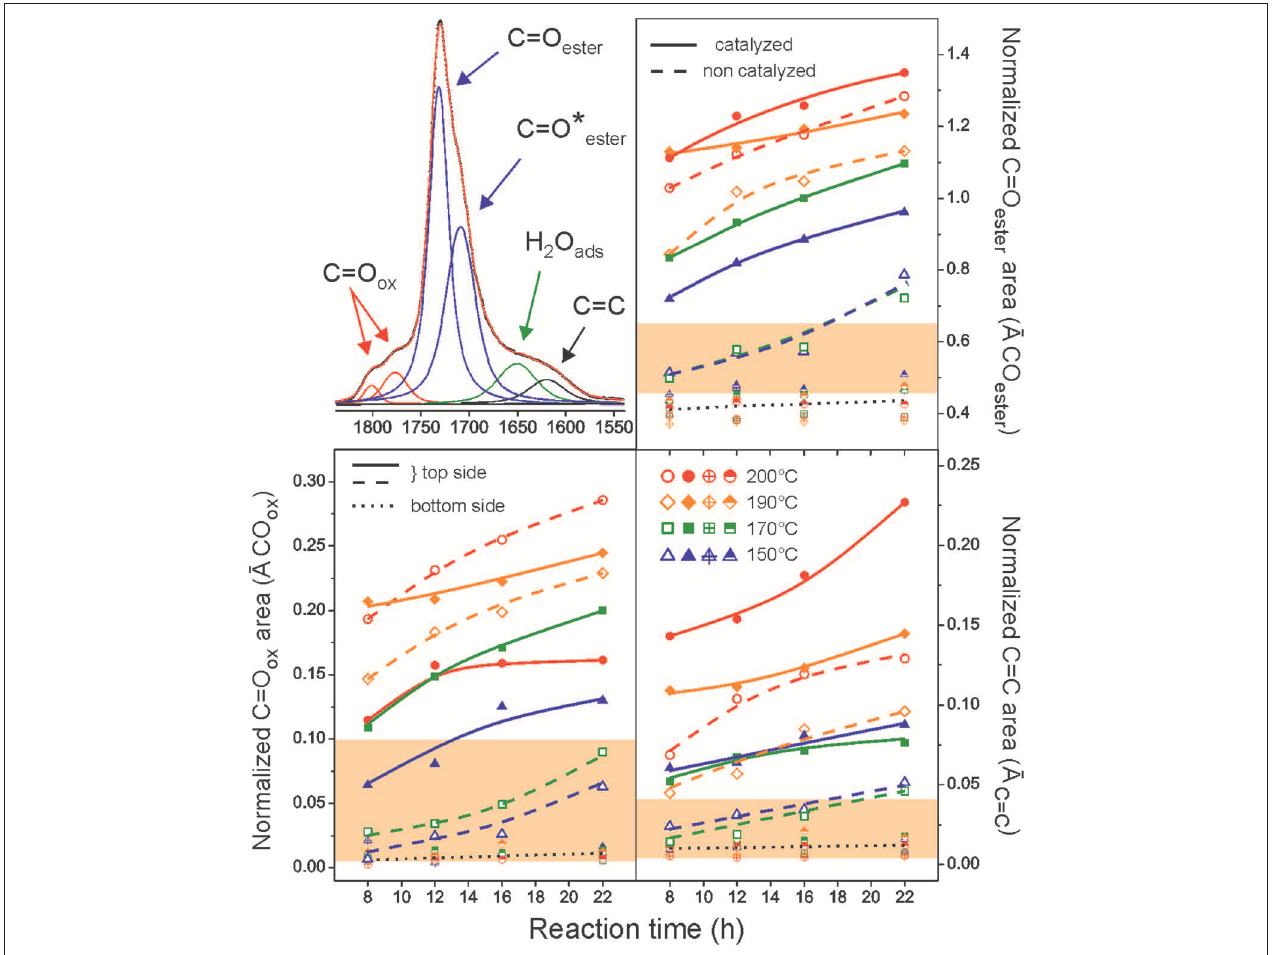
FIGURE 1 | ATR-FTIR band area evolution (normalized to the area of the methylene group stretching) of detected species in polyaleuritates films prepared in air as a function of time and reaction temperature. Data for the air exposed (top) and air preserved (bottom) sides are shown. The filled regions (light red areas) correspond to the value range obtained from the corresponding bulk transmission IR spectra of both (catalyzed and non-catalyzed) series. In the upper left corner the ATR spectrum of the air-exposed side of the polymer in the 1,825–1,540 cm − 1 region and its main contributors are included. Asterisk denotes crystalline phase and/or hydrogen bond ester (C=O)